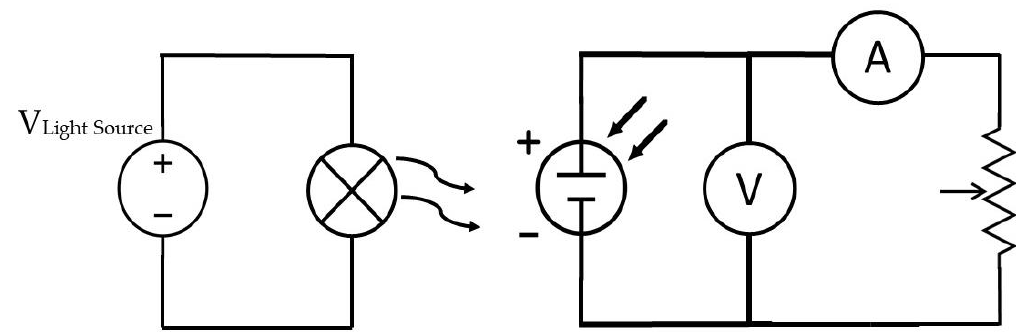
Figure 10. Measurement setup for solar cell characterization.